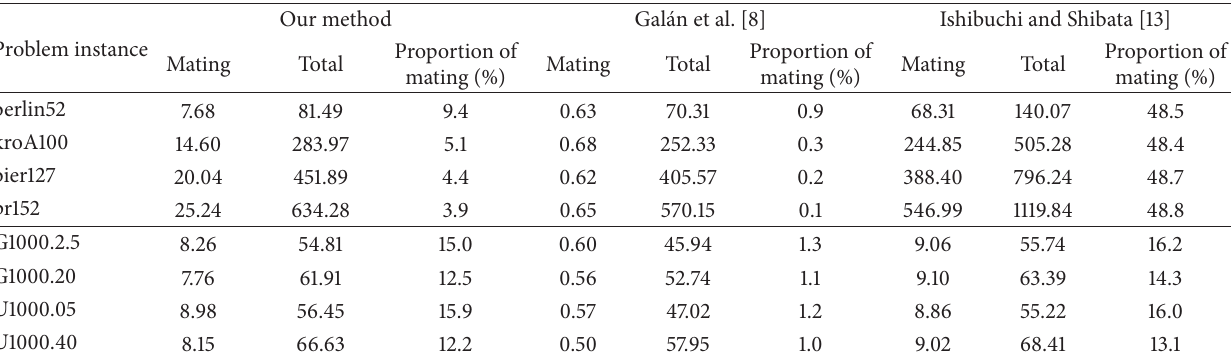
Table 7: Results of computation